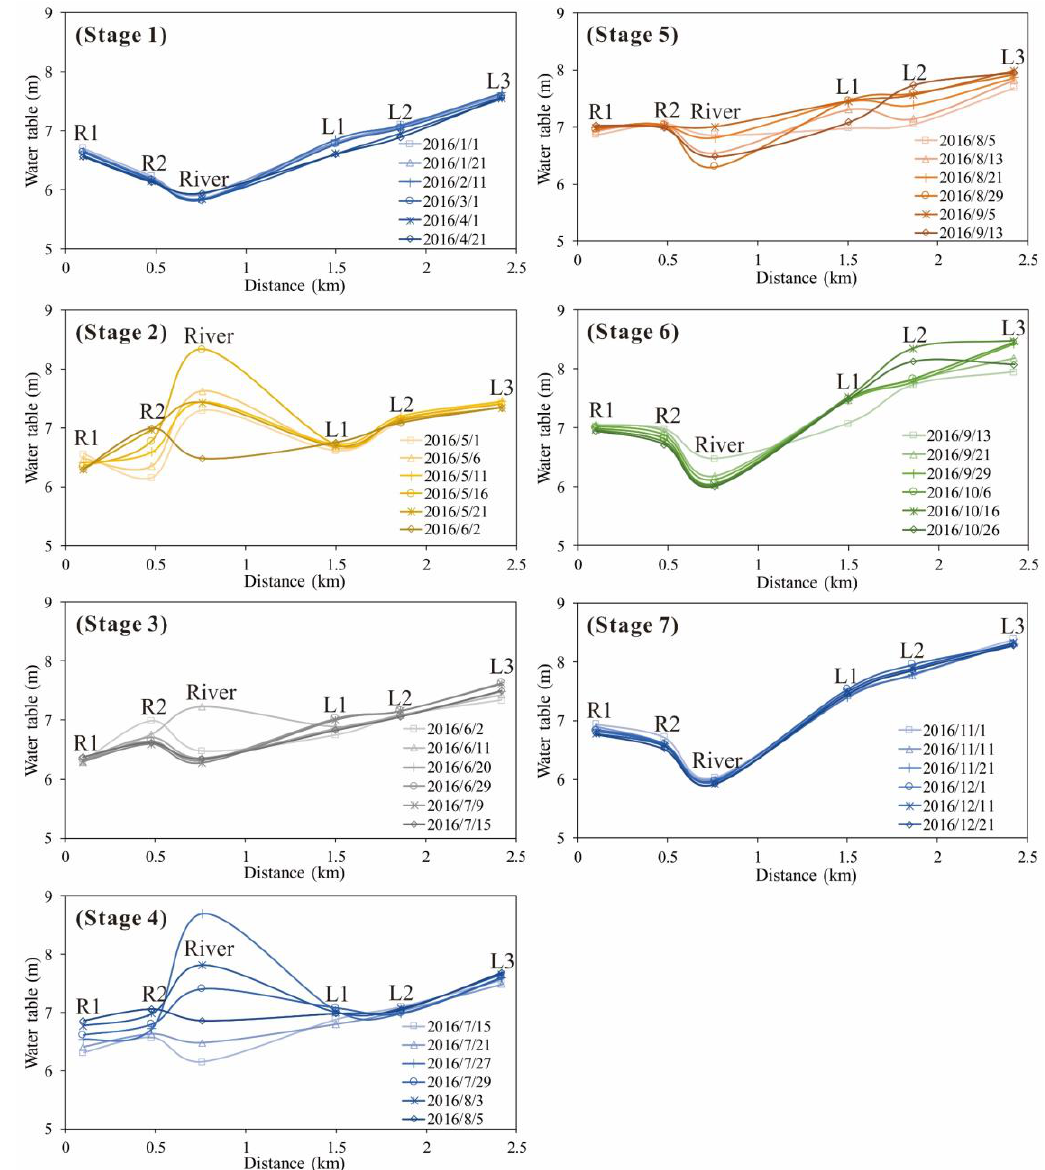
Figure 6. Changes in the water level of the XLZ section at different stages (R1 and R2 represent the groundwater monitoring points XLZ-R1 and XLZ-R2 on the right bank, respectively; L1, L2, and L3 represent the XLZ-L1, XLZ-L2, and XLZ-L3 points on the left bank, respectively).